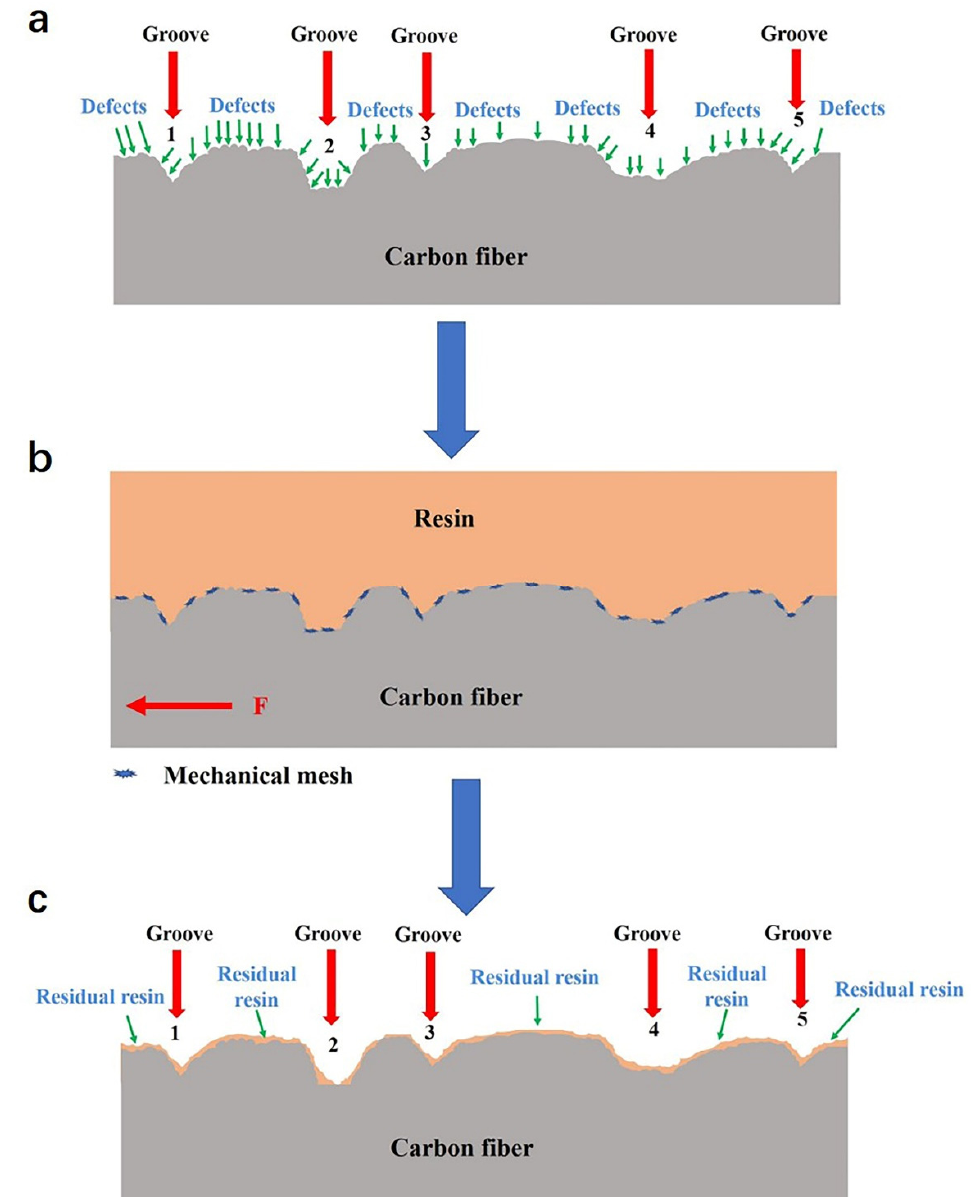
Figure 12. Schematic diagram of: ( a ) CF surface microstructure, ( b ) composite interface structure, ( c ) composite fracture morphology.